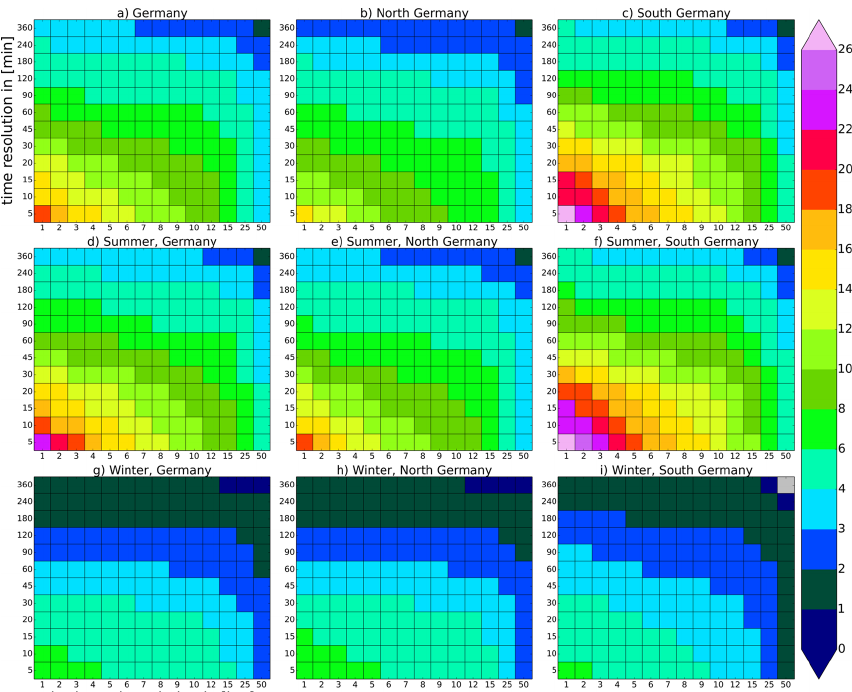
Figure 3. Convective extremes as a function of resolution. The 99th percentile of convective precipitation intensities, aggregated over dif- ferent parts of Germany for the years 2007–2008, on different horizontal (horizontal axis) and temporal (vertical axis) resolutions: entire year (a–c) , summer season (d–f) and winter season (g–i) . All of Germany (a, d, g) , northern Germany (b, e, h) , southern Germany (c, f, i) ; intensities given in mmh − 1